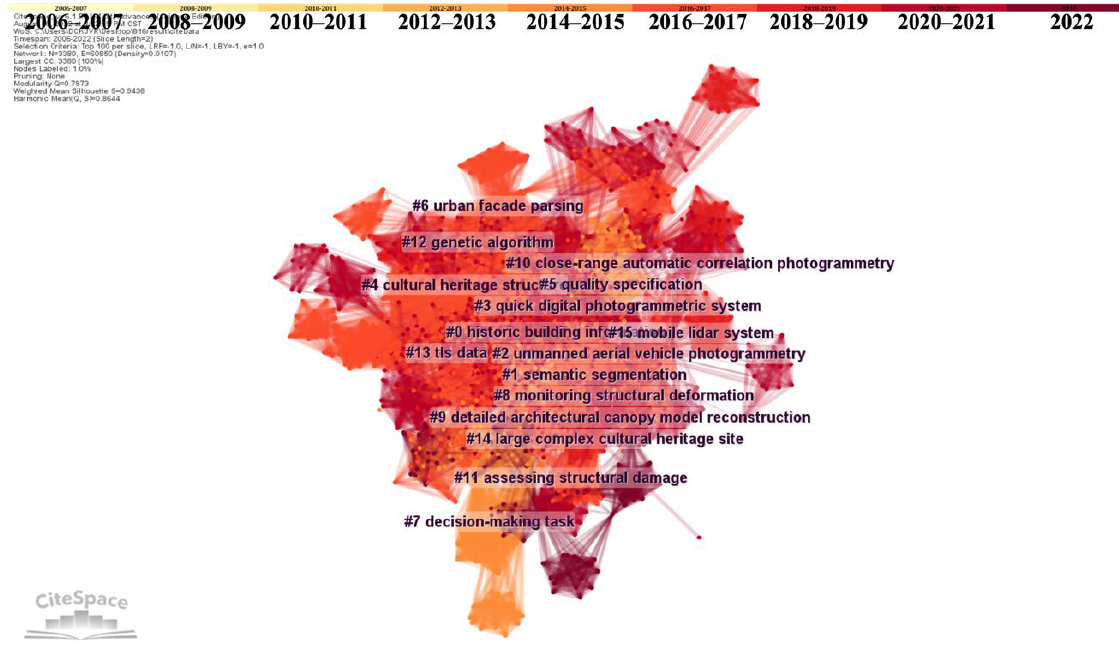
Figure 4. The term co-occurrence network and cluster analysis results.